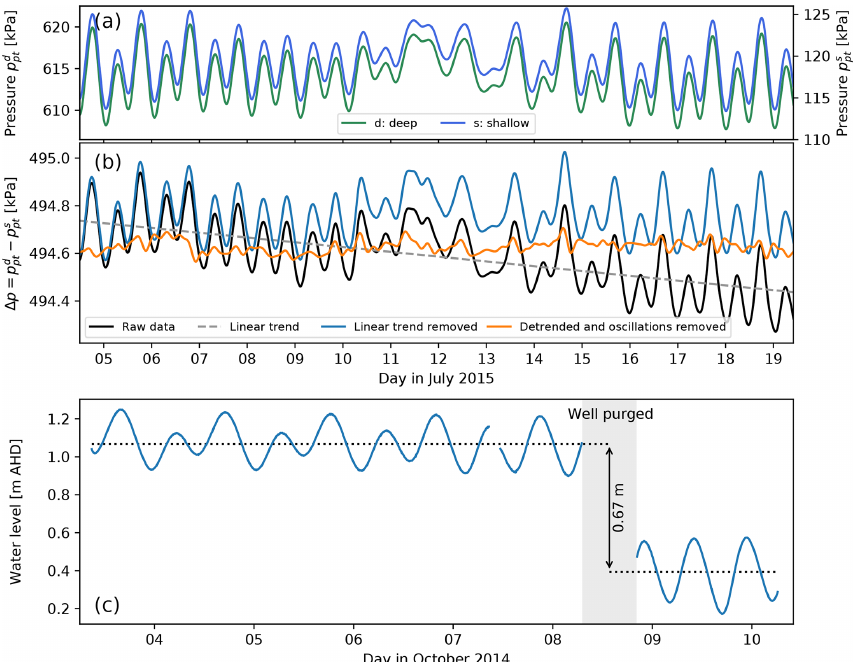
Figure 7. (a) Time series of water level pressure recorded by two transducers, a shallow (superscript s) and deep (superscript d) transducer, located in the same well. (b) Difference between the deep and shallow pressure measurements. (c) Water level in an observation well showing offset in mean water level after the well was purged for hydrochemical sampling (AHD is Australian Height Datum). Note that due to the high temporal resolution, the discrete measurement points are not shown and the time series are drawn as lines instead.